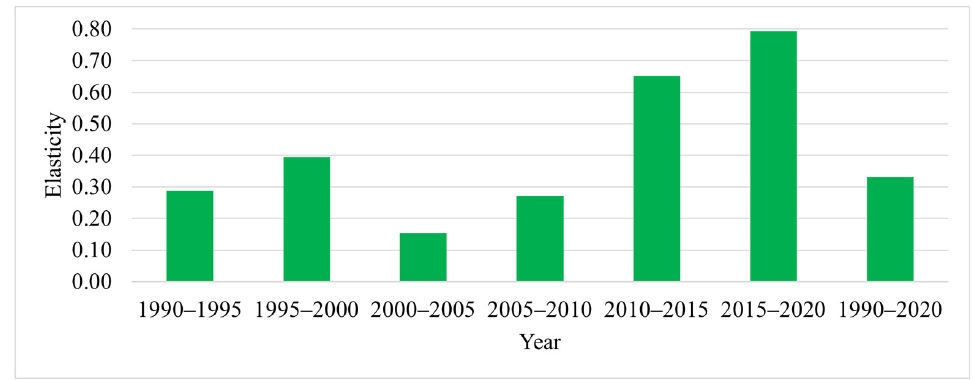
Figure 7. Elasticity of ESV in response to LULC change.